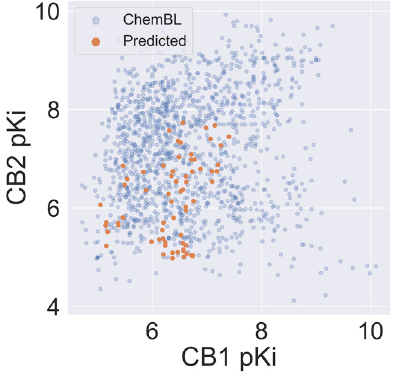
Figure 5. The correlation between affinity against CB1 and CB2 for compounds in Cannabis sativa and compounds reported in ChEMBL.